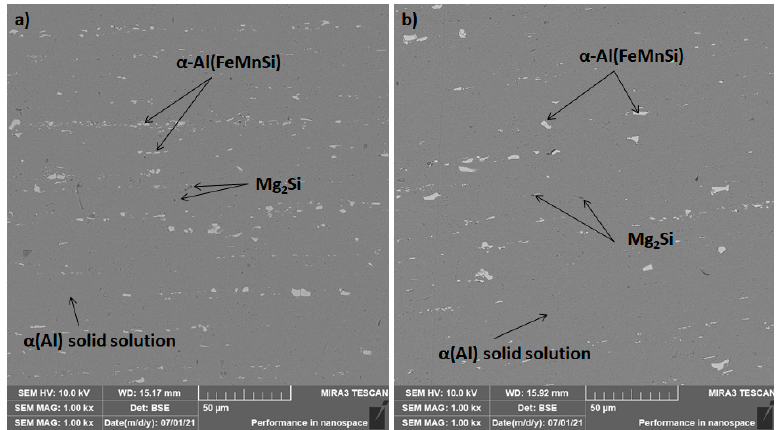
Figure 9. Microstructure of HAZ after welding three weld beads at a distance of 4 mm from the fusion line ( a ), with preheating at 75 °C ( b ) and 150 °C.